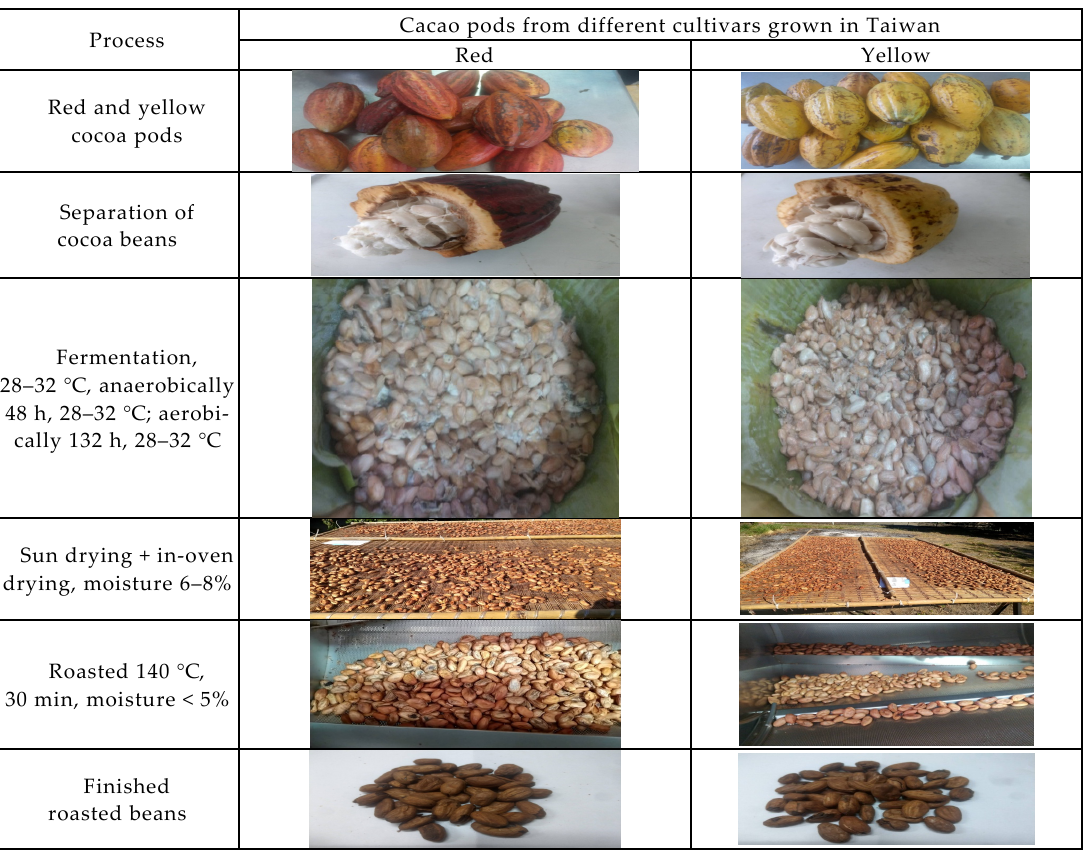
Figure 3. The three main processes (fermentation, drying, and roasting) for preparation of samples of roasted cocoa beans in this study.